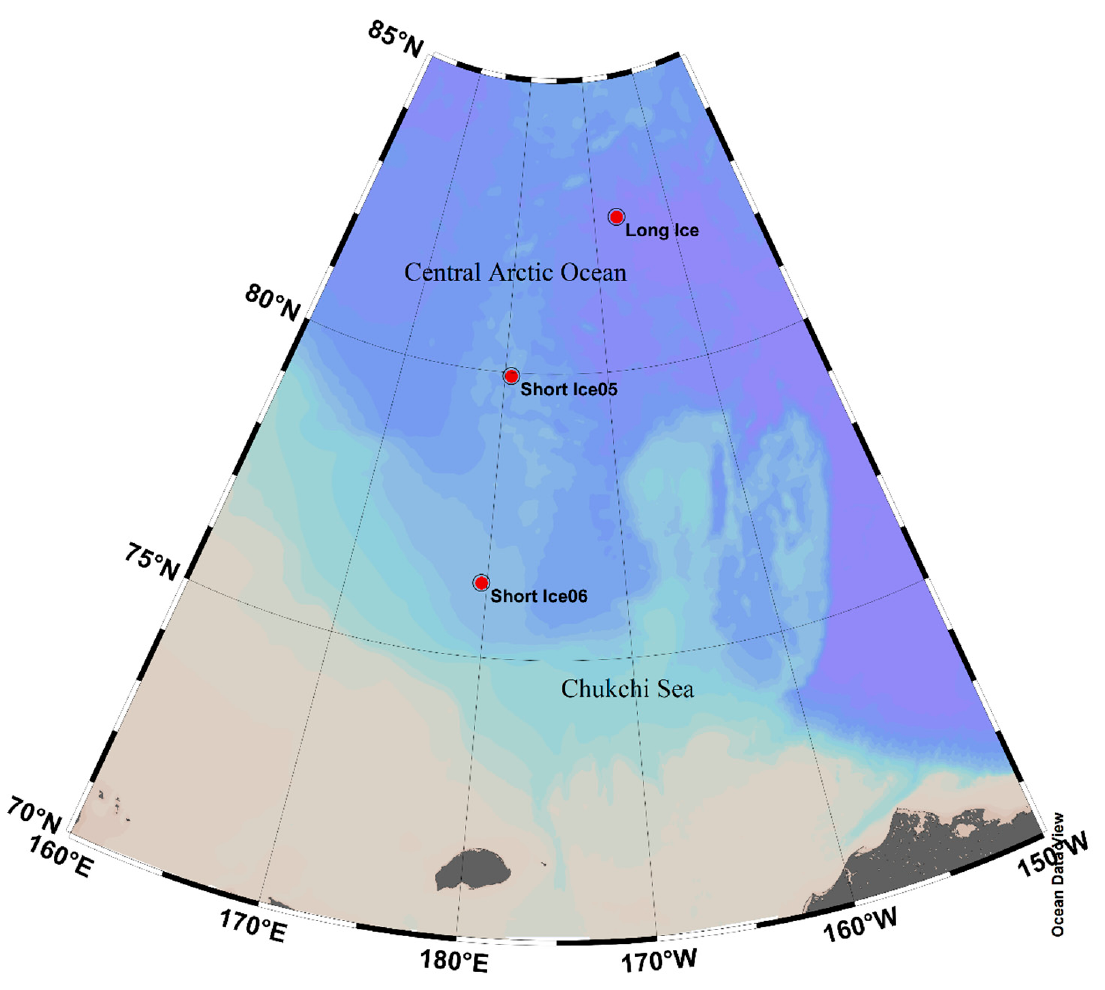
Figure 1. Map of ice stations during CHINARE 2016. The sampling times were 18 August 2016 (SI05), 20 August 2016 (SI06) and 14 August 2016 (Long Ice), respectively.